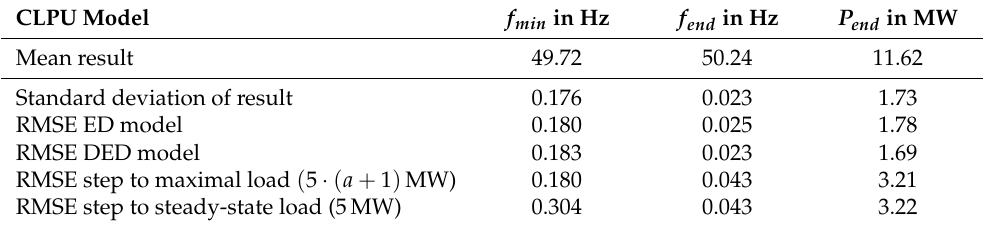
Table 3. Simulation results and mean deviation depending on CLPU model: RMSE between simula- tion result with respective model and simulation results using recorded current time series. CLPU Model